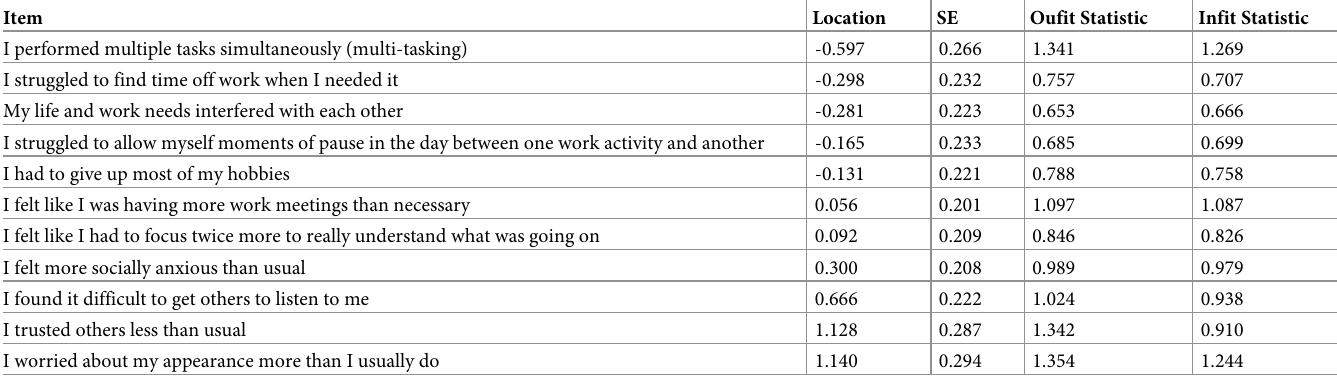
Table 5. Partial credit model and item fit